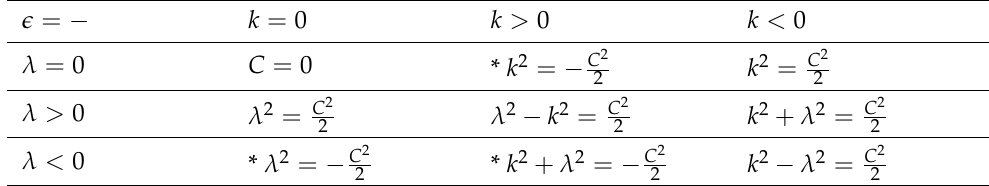
Table 2. Possible relations between the constants for the phantom sector, (cid:101) = − 1. ∗ indicates the cases that give complex values for the constants, which are not of interest.